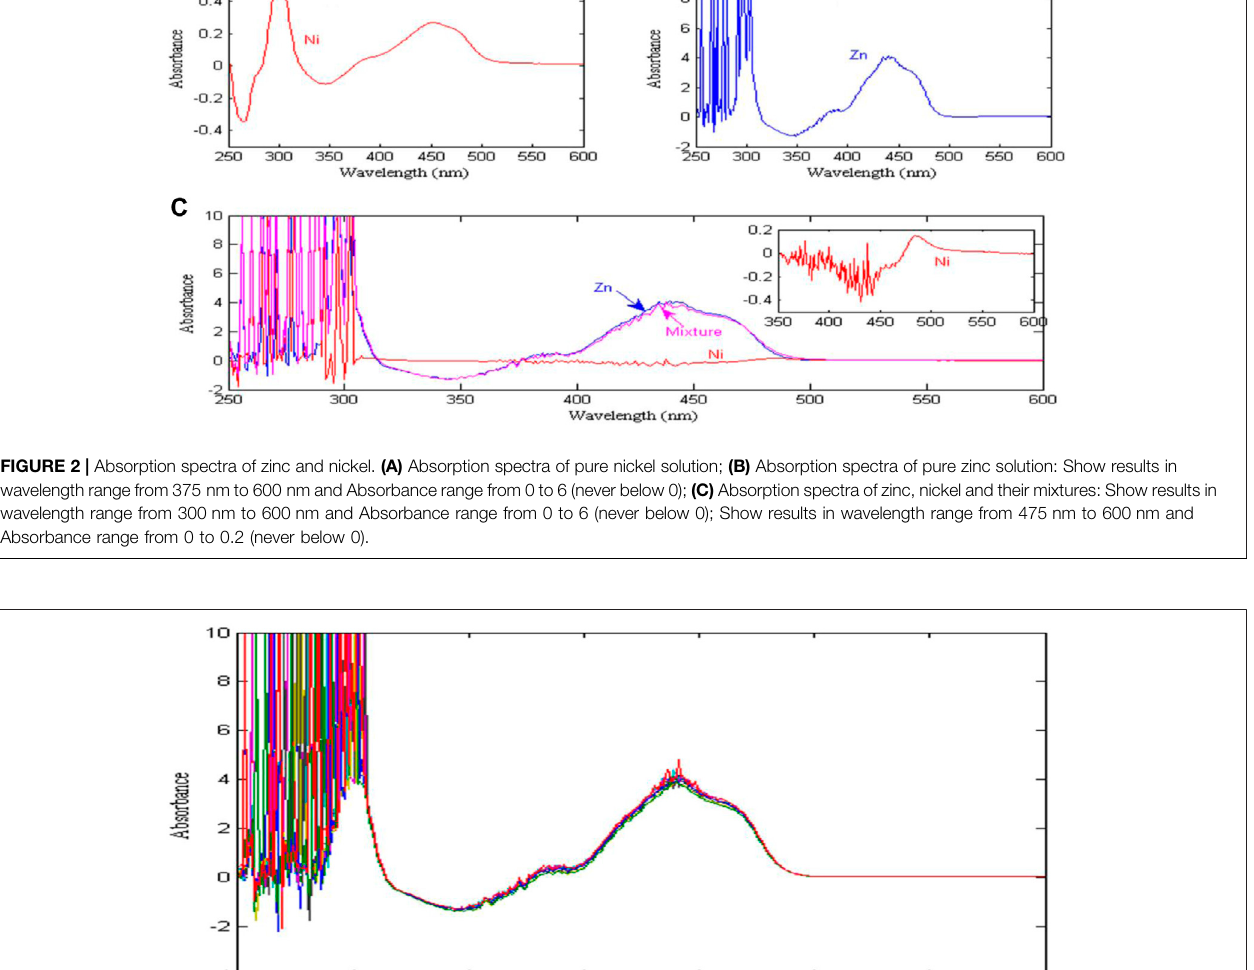
Frontiers in Chemistry |